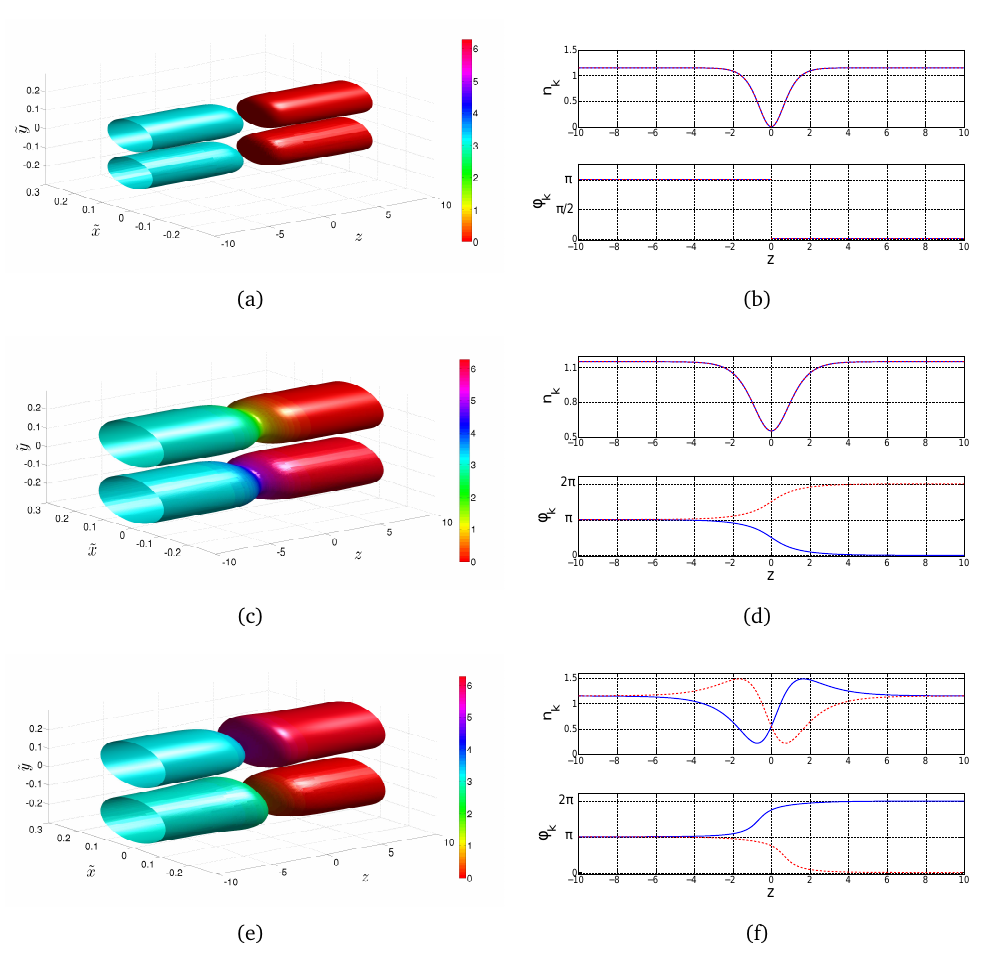
= 0) in a coupled two-component BEC: (a) Figure 2: Stationary solitary-wave solutions ( v s & (b) Dark soliton, (c) & (d) Josephson vortex, and (e) & (f) Manakov soliton at θ = − π/ 4. ( z ) = | ψ ( z ) | 2 is encoded in the width of the tube and the phase Left column: The density n k k ( z )] in the colour. The upper tube corresponds to component 1 and the lower one to arg [ ψ k ( z , ˜ x , ˜ y ) = n ( z ) exp [ − ( ˜ y ± 0.15 ) 2 + ˜ x 2 ] and plot isosur- component 2. Specifically we define N k k 0.1 2 = 0.3. Right column: density (top panels) and phase (bottom panels) faces at the value N k profiles are shown directly as a blue dashed line (component 1) and a red dashed line (com- = 2 π ( 1 + ν ) for all ponent 2). Other parameters are γ = 1, ν = 0.15, P c